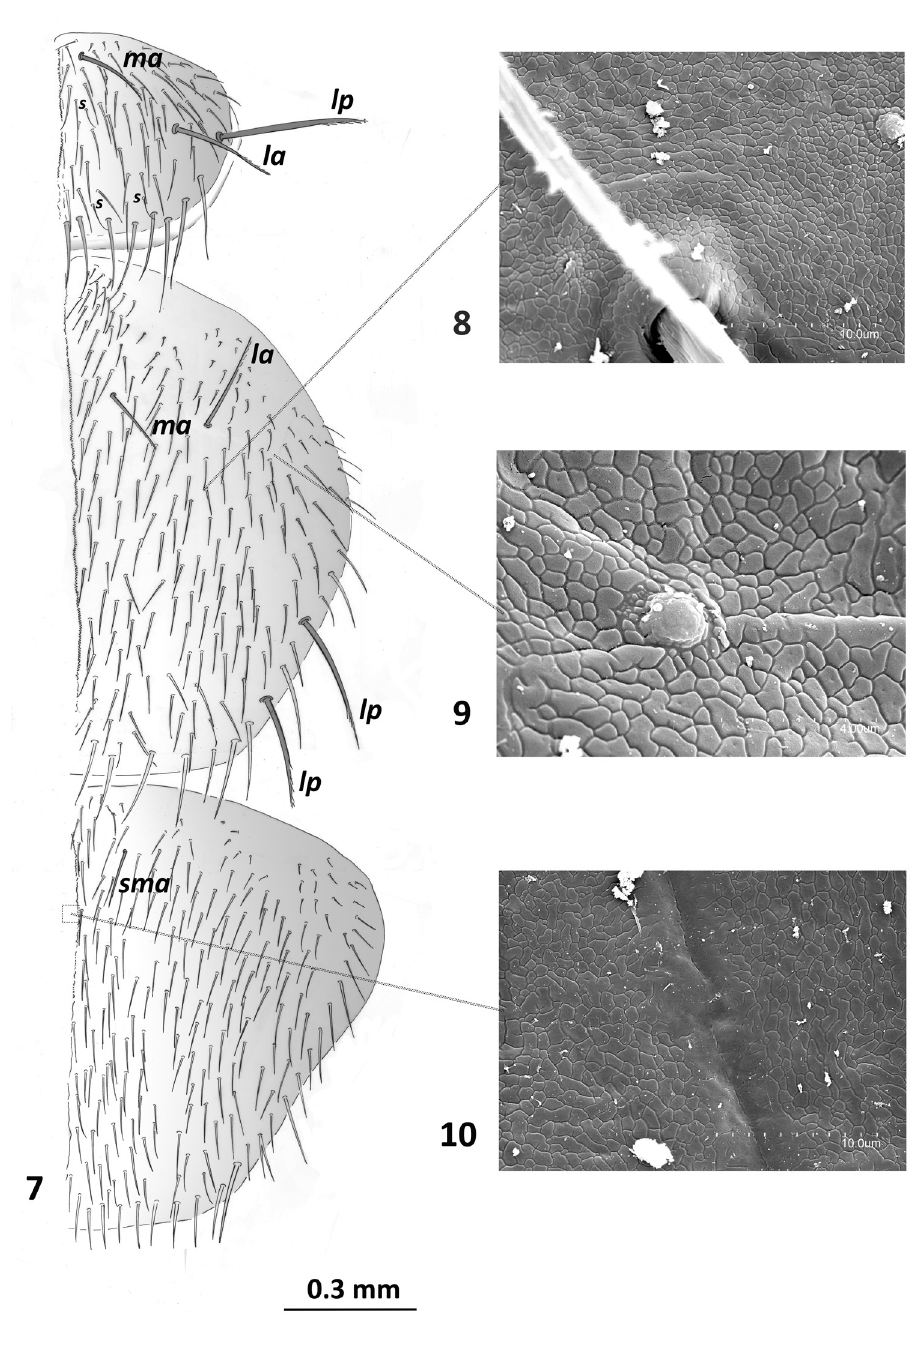
8 detail epicuticle surface on mesonotum, paratype 9 detail epicuticle surface including external gland in the middle on mesonotum, paratype 10 detail epicuticle surface and the ecdysial suture on metanotum,